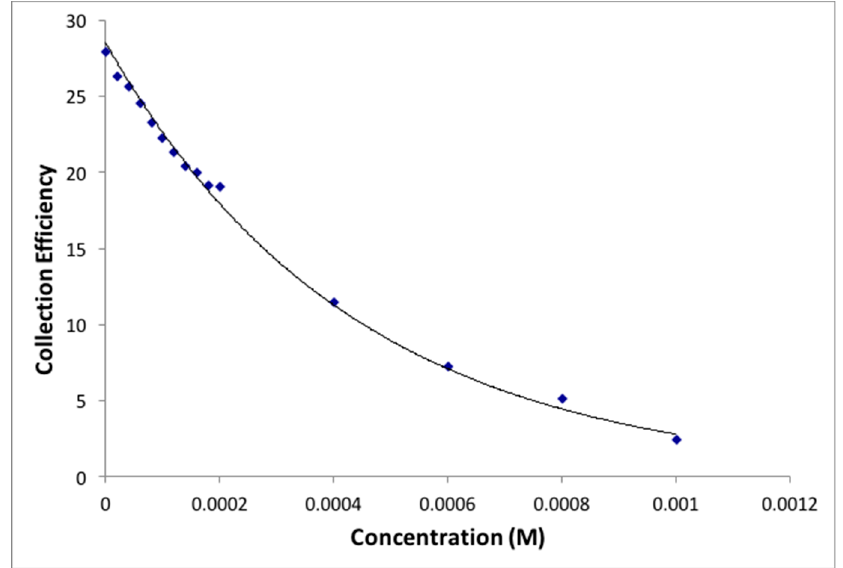
Figure 12 Collection efficiency for quercetin. Figure 12. Collection efficiency for